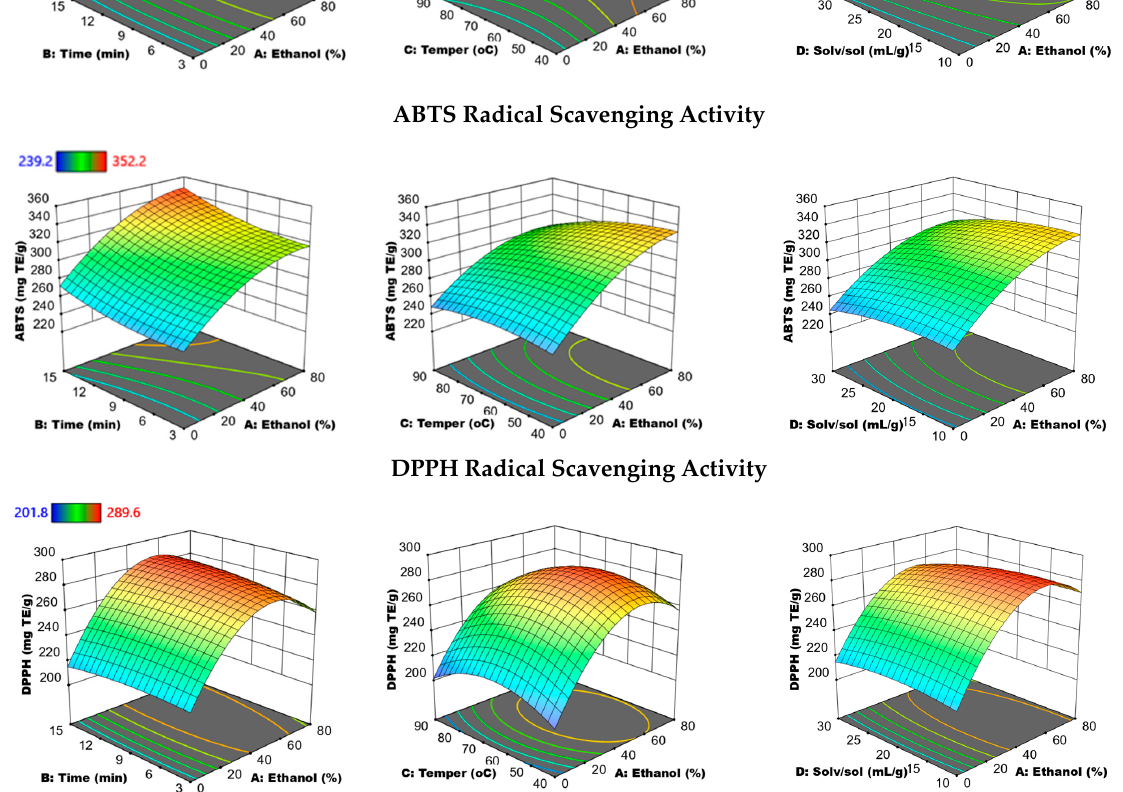
Figure 2. Response surface plots showing the combined effects of the MAE parameters (% ethanol- time, % ethanol-temperature, and % ethanol solvent-to-solid ratio) on the extraction yield, total phenolic content, ABTS, and DPPH radical scavenging activity by keeping the two independent variables constant at medium levels.